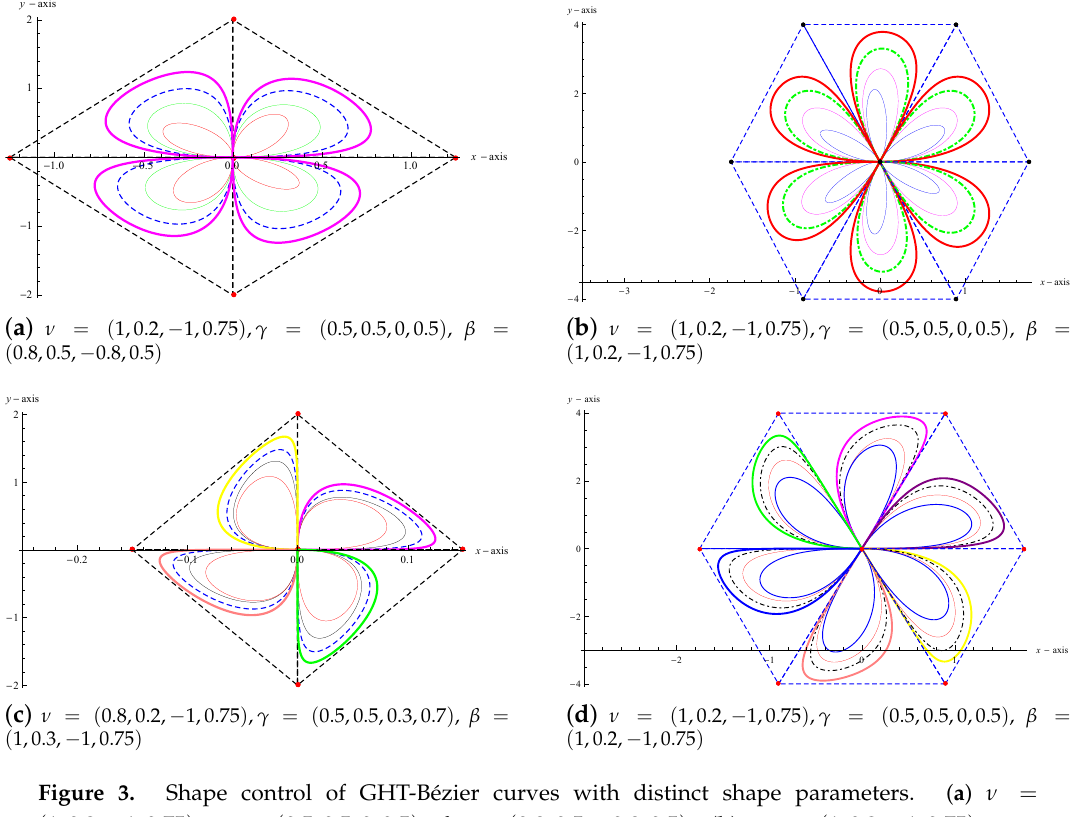
0.8,0.5 ) ; ( b ) ν = ( 1,0.2, 1,0.75 ) , γ = − − 1,0.75 ) , γ = ( 0.5,0.5,0.3,0.7 ) , β = − 1,0.75 ) −